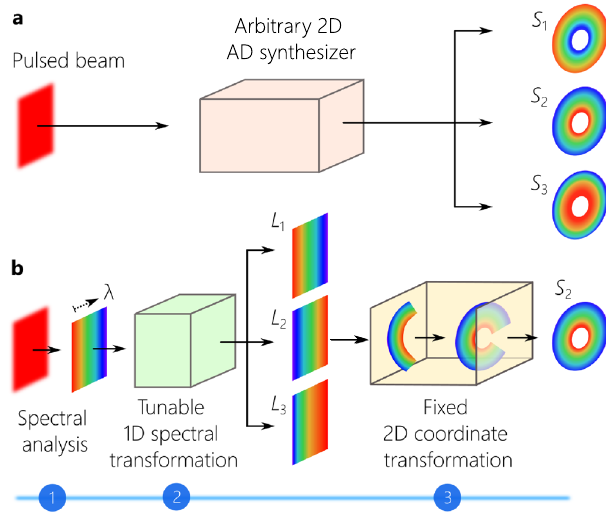
Fig.2|Synthesisstrategyfor3DSTwavepackets.a Startingwithagenericplane- wave pulse, we aim at constructing an angular-dispersion synthesizer in two dimensions that arranges the wavelengths in circles in a prescribed order. S 1 cor- responds to a subluminal wave packet, whereas S 2 and S 3 correspond to super- luminal wave packets of different group velocities. b The proposed strategy comprises spectral analysis followed by a tunable 1D spectral transformation that rearranges the initial wavelength sequence in the spectrally resolved wavefront. The 1D spectra L 1 , L 2 , and L 3 are rectilinearcounterparts of S 1 , S 2 , and S 3 in a . In the third stage, a fi xed 2D conformalcoordinate transformation converts vertical lines into circles, thereby realizing the targeted spatio-temporal spectra S 1 , S 2 , and S 3